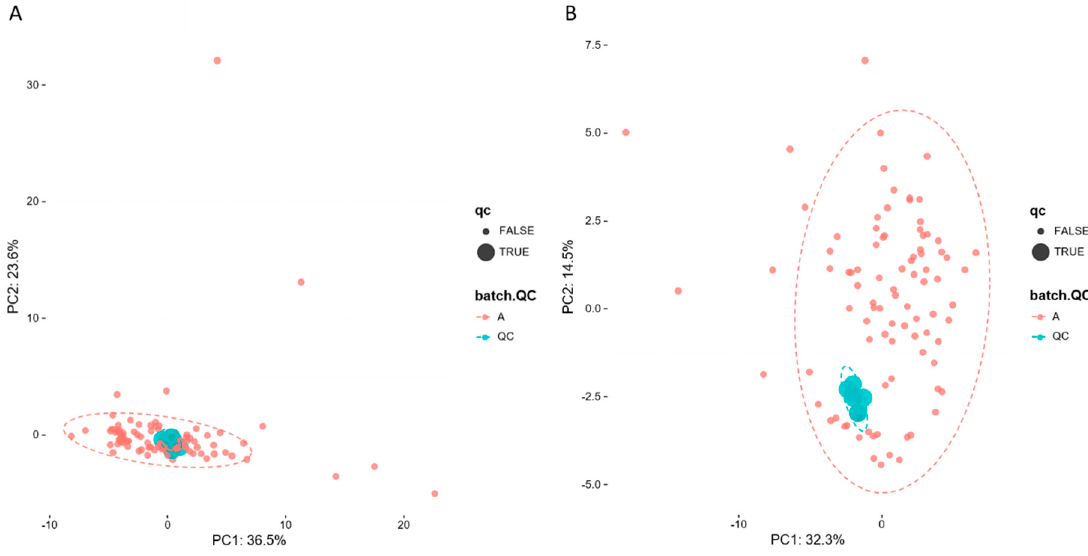
Figure 3. PCA of lipids in samples and QCs: ( A ) positive ion mod; ( B ) negative ion mod.